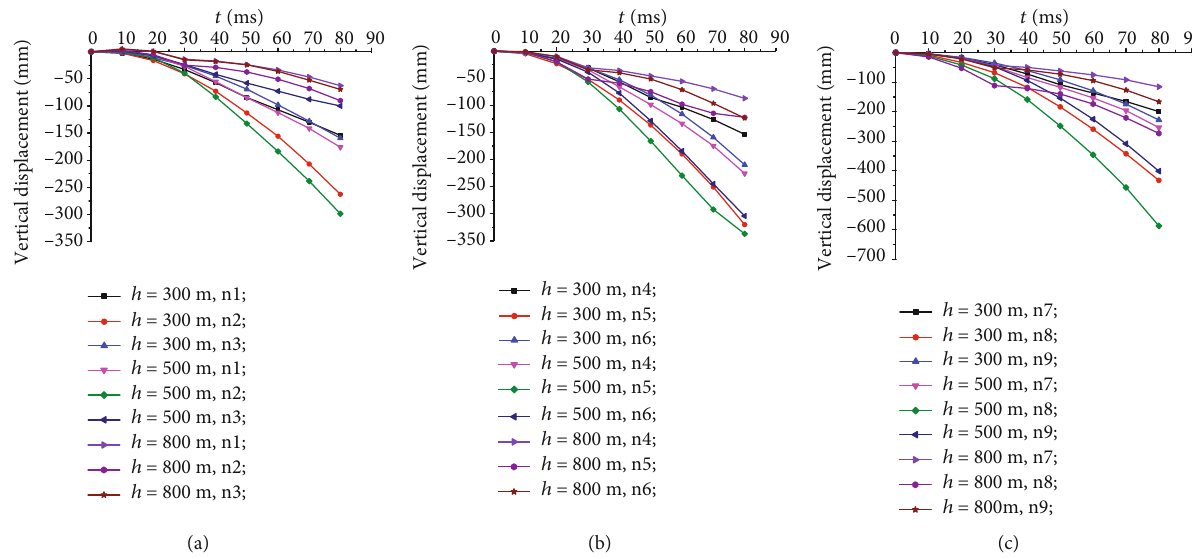
Figure 7: The vertical displacement at the 9 measuring points in the conditions of H = 300 , 500, and 800m: (a) n1 ~ n3 on HL1; (b) n4 ~ n6 on HL2; (c) n7 ~ n9 on